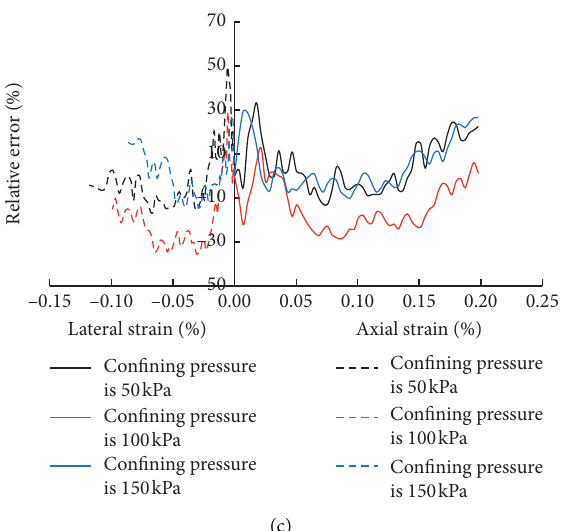
Figure 12: Relative error between the numerical calculation results and the triaxial test results: (a) degree of compaction is 90%; (b) degree of compaction is 93%; (c) degree of compaction is 96%. Table 3: Absolute value of relative error of axial strain (%). Degree of compaction